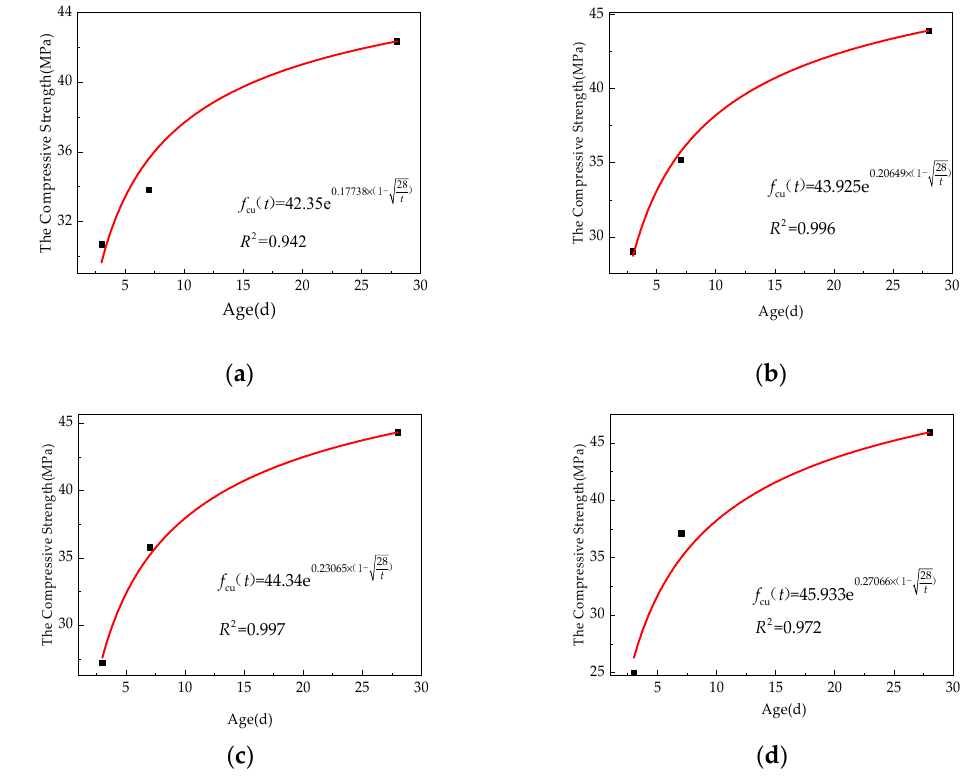
Figure 8. These are modified formulas of compressive strength of SCC with low fly ash and silica fume content. ( a ) Fitting formula with fly ash replacement rate of 0%; ( b ) fitting formula with fly ash replacement rate of 10% ( c ) fitting formula with fly ash replacement rate of 20%; ( d ) fitting formula with fly ash replacement rate of 30%. Table 7. Relationship between Coefficient a and Compressive Strength.